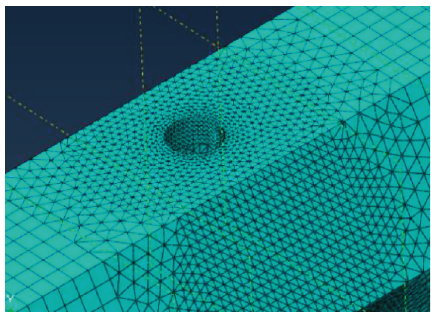
Figure 7: Meshing results for the circular through-hole damage.